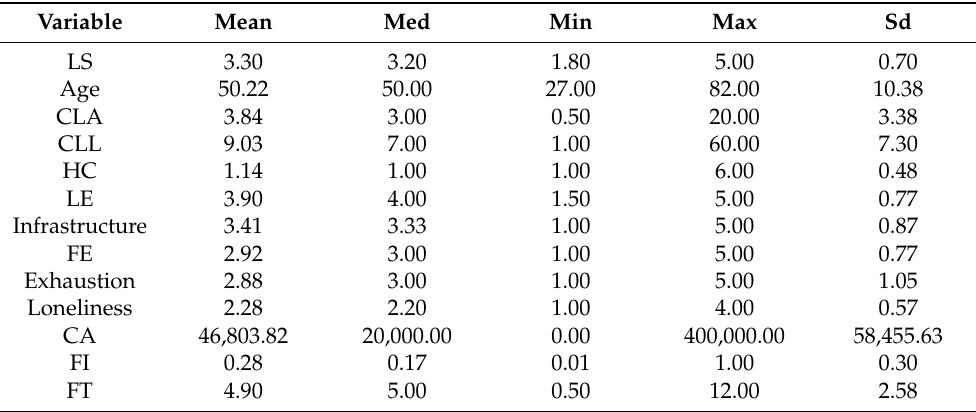
Table 4. Descriptive Statistical